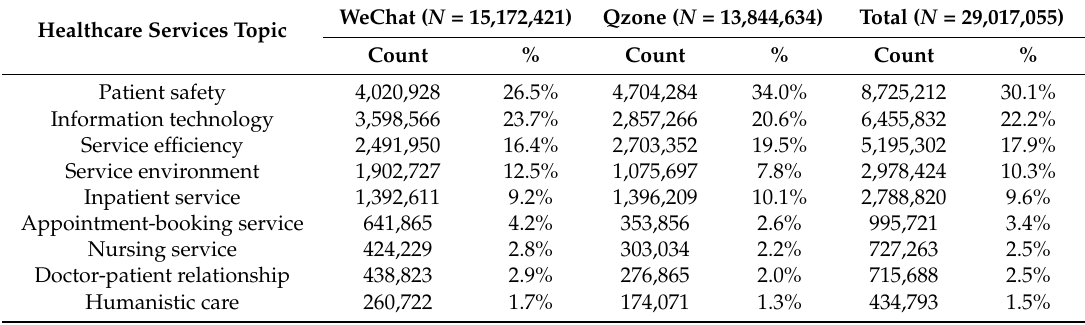
Table 3. Distribution of each topic content volume (count and proportion), 15 June 2017